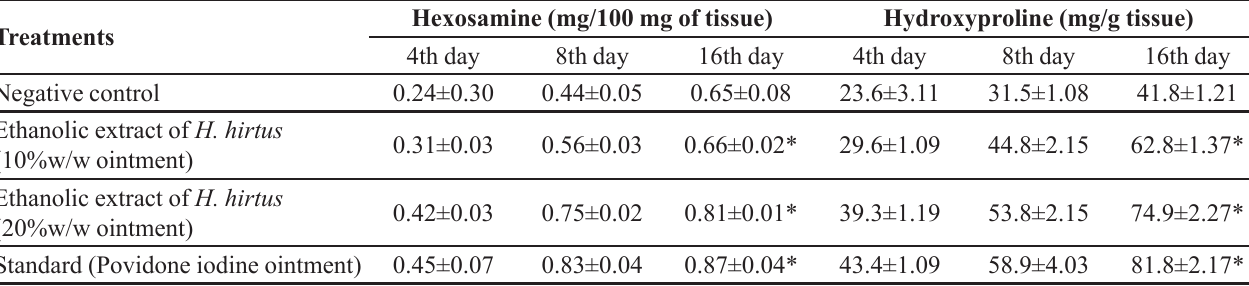
TABLE III - Hexosamine and hydroxyproline content of granulation on different days of healing